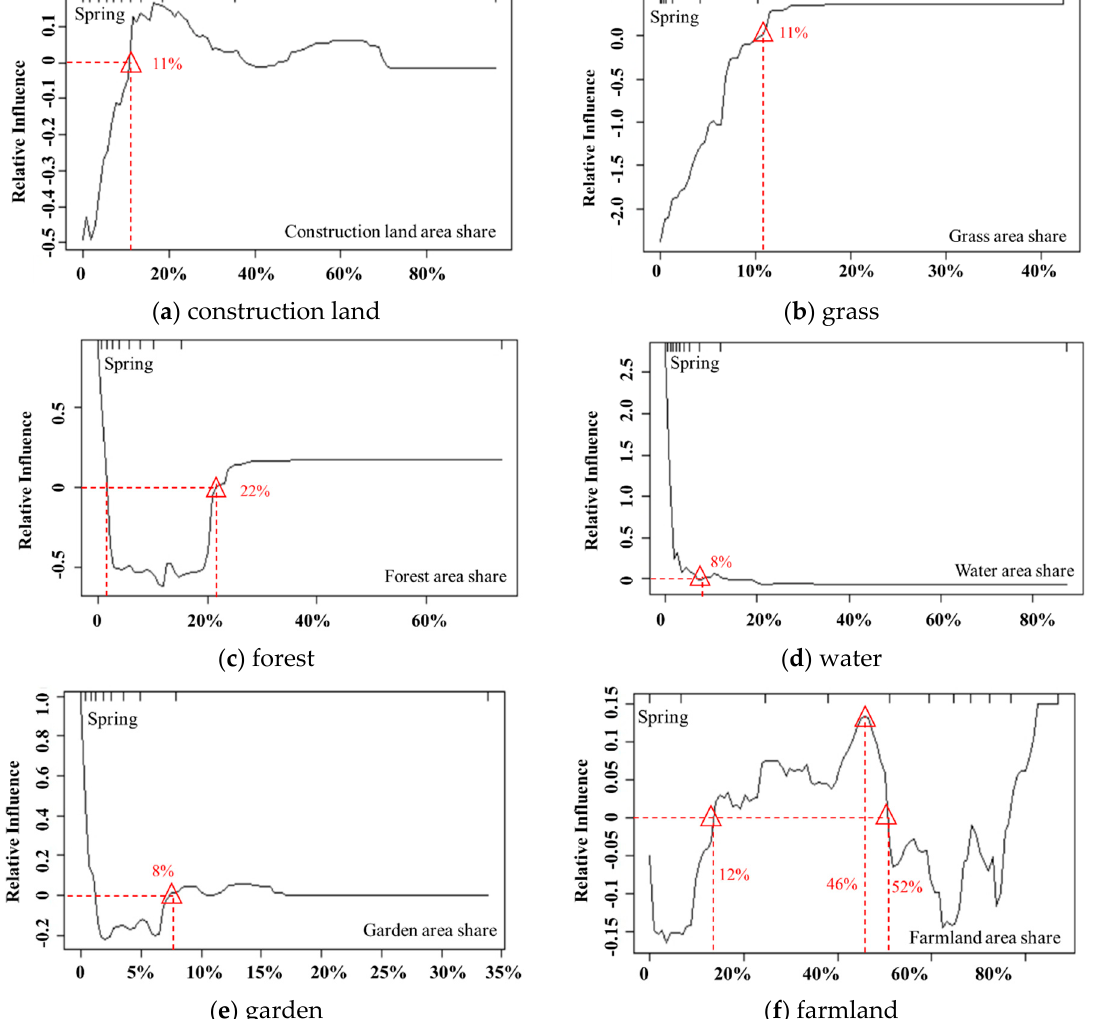
Figure 6. The influence of the main factors (concentration rate >10%) on PM 2.5 in spring.